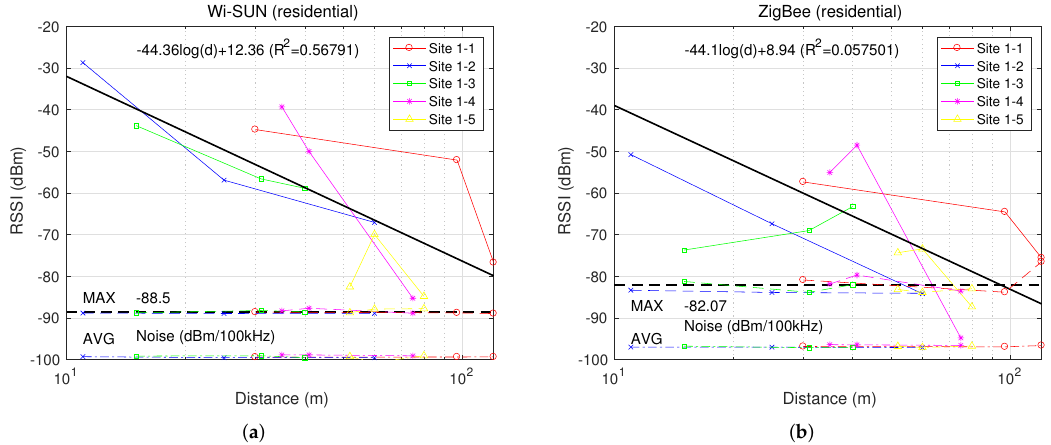
Figure 25. RSSI values for the Overhead Residential Area. ( a ) Wi-SUN. ( b ) ZigBee.